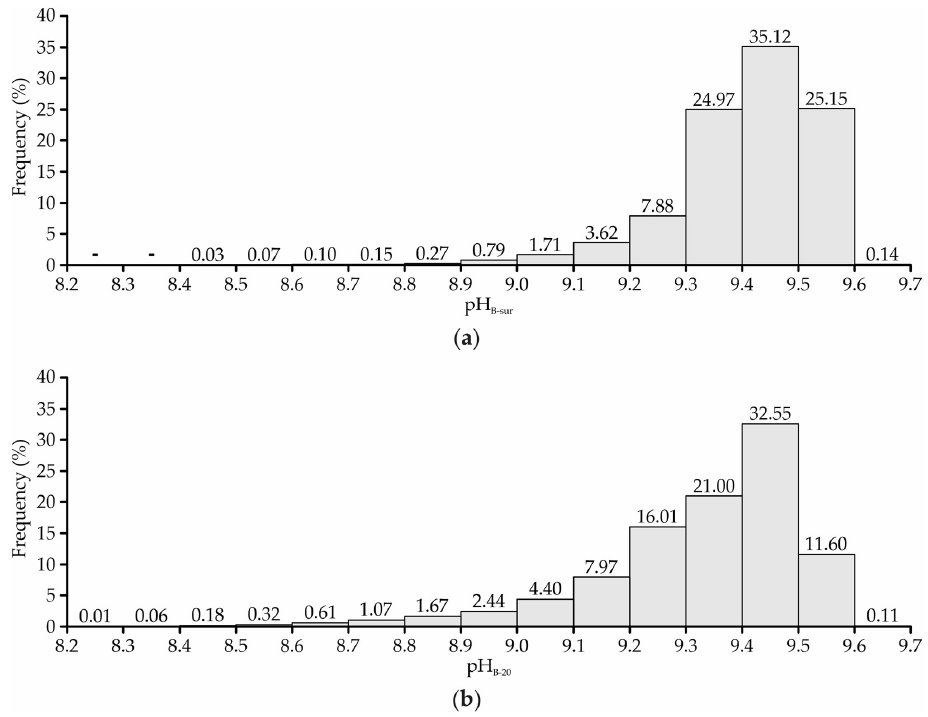
Figure 8. Frequency distribution of bedding hydrogenionic potential at the surface—pH B-sur ( a ) and at a depth of 0.2 m—pH B-20 ( b ).